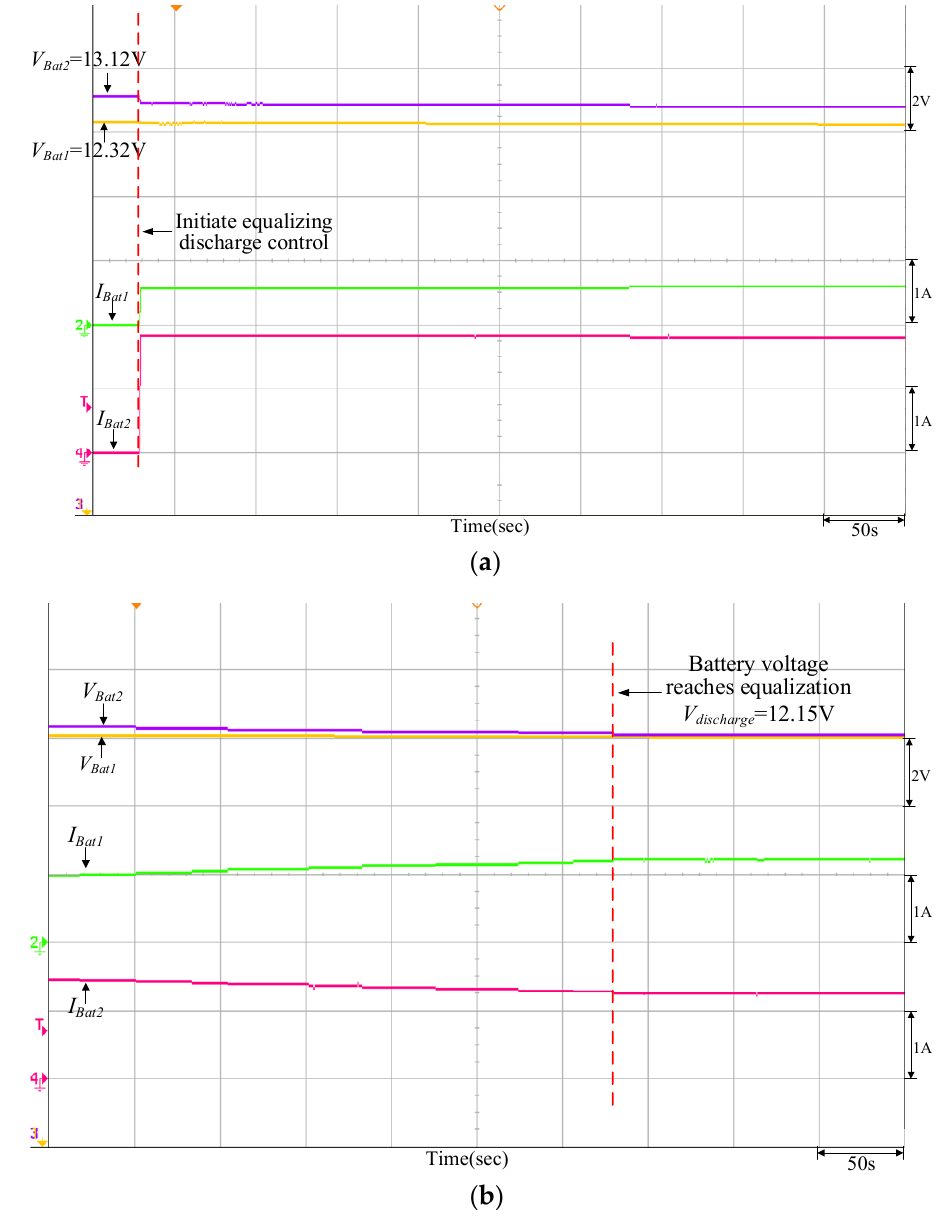
Figure 18. Equalizing discharge control response of the traditional P-I controller when V Bat1 = 12.32 V and V Bat2 = 13.12 V: ( a ) initiate equalizing discharge control; ( b ) reach equalizing discharge equalization.